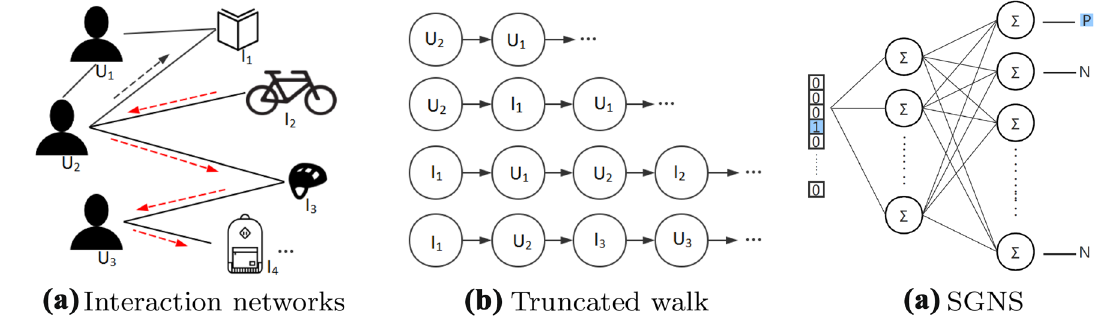
Fig. 4 Overview of co-occurrence